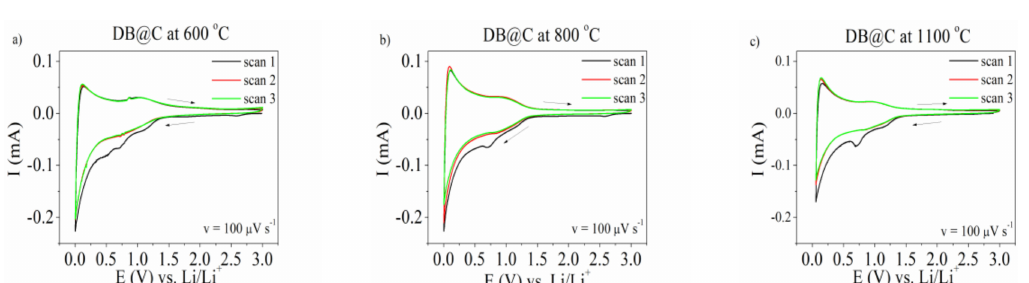
Figure 7. The cv curve of DB@C electrode material pyrolysed at different temperatures ( a ) 600 ◦ C, ( b ) 800 ◦ C, and ( c ) 1100 ◦ C in 1M LiPF6 in EC / DMC. Potential range 0.002–3 V. Sweep rate v = 100 µ V s − 1 .